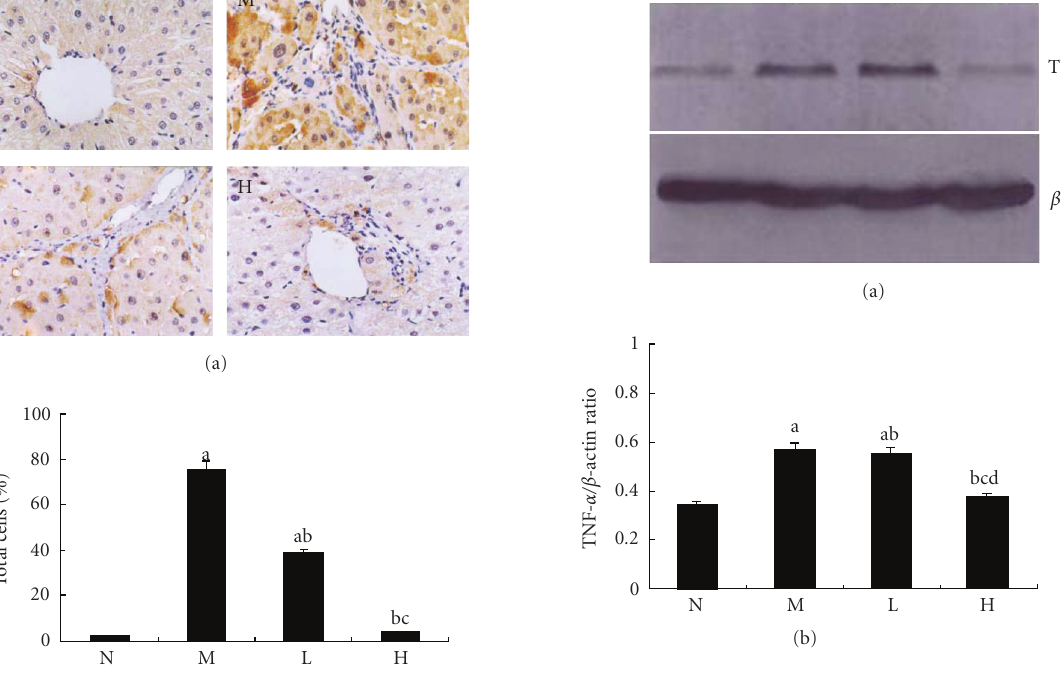
Figure 8: Expression of TNF- α protein in rat liver using Western blot analysis. (a) Lane 1 represented the normal control group (N); lane 2 represented the model group (M); lane 3 represented the group treated with low dose of thalidomide (L); lane 4 represented the group treated with high dose of thalidomide (H). β -actin served as an internal control. (b) Comparison of the expression of TNF- α protein using Western blot analysis. a P < . 01, b P < . 05 versus normal control group; c P < . 01 versus model group; d P < . 01 group treated with high dose of thalidomide versus group treated with low dose of